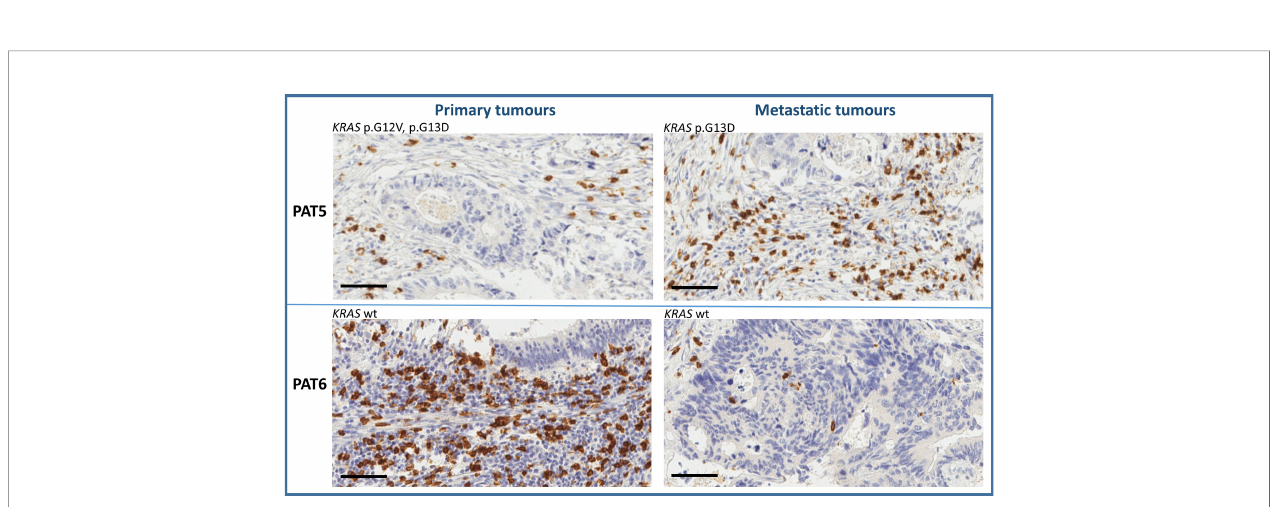
FIGURE 3 | Representative immunohistochemistry of GrzB + cells in tumor cores of PAT5 and PAT6 (bar = 100